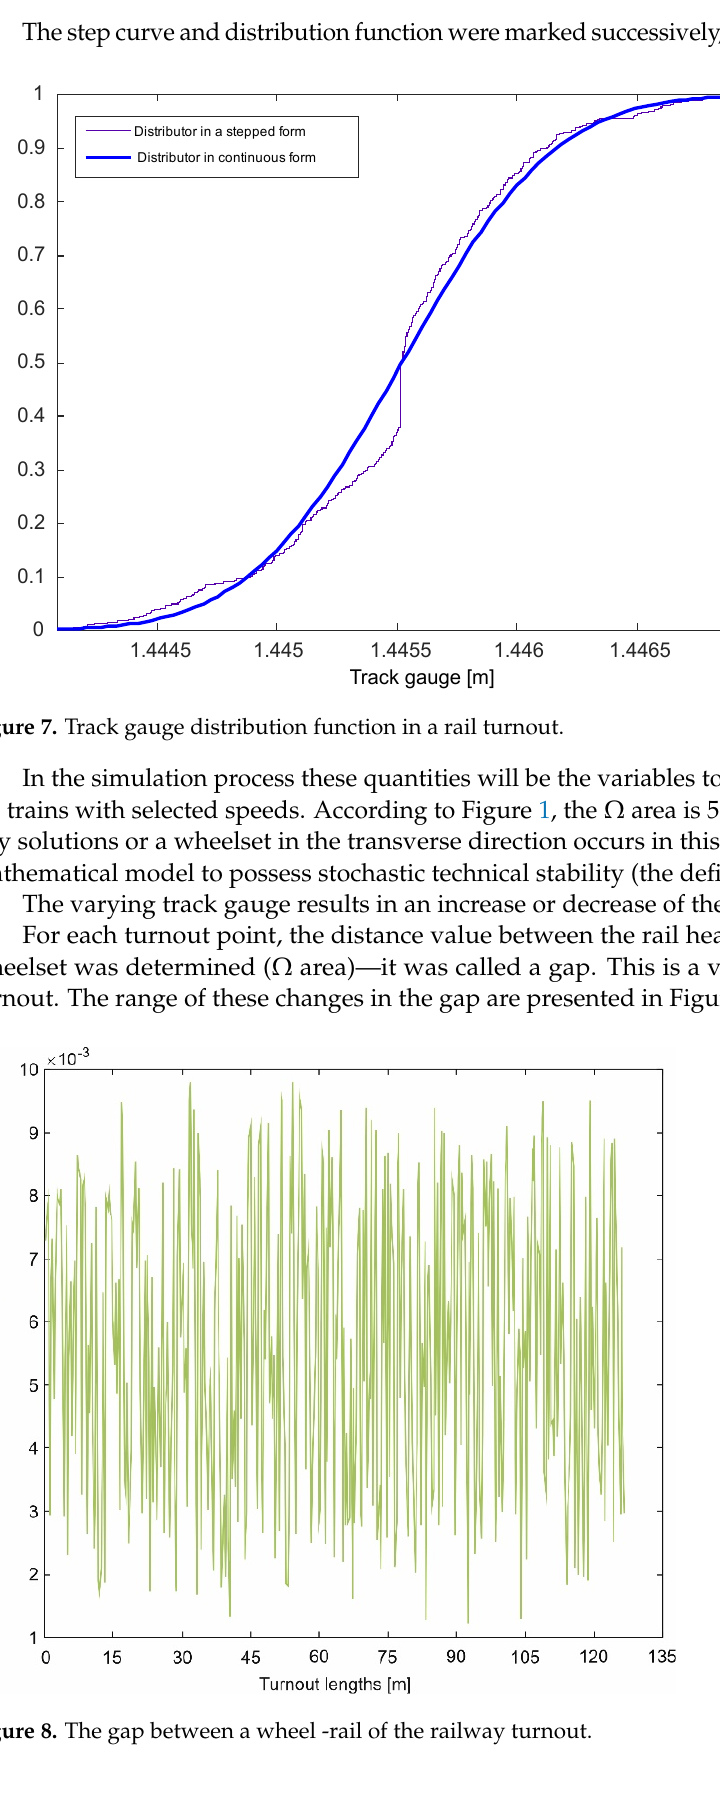
Figure 6. Track gauge normal distribution in the rail turnout. The step curve and distribution function were marked successively, as shown in Figure 7.